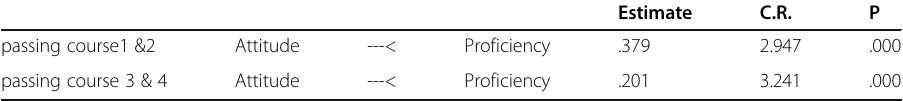
Table 12 Standardized Regression Weights: (data - Default model) for participants that they passed current Aviation courses (CBLT courses) held by the Iranian general directorate of